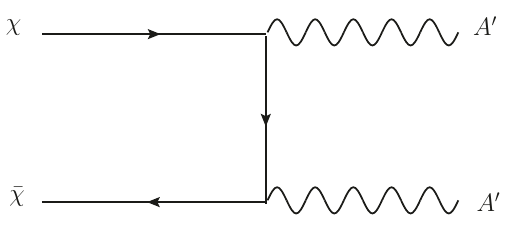
Figure 1 . Annihilation of DM (cid:31) into \dark photon" pairs, which later decay into SM states (only t -channel